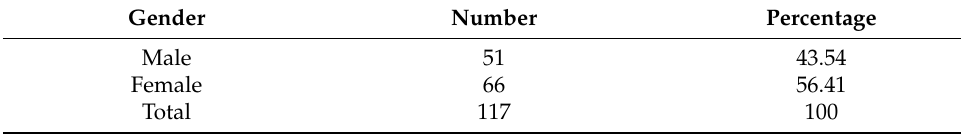
Table 3. Gender of the participants.